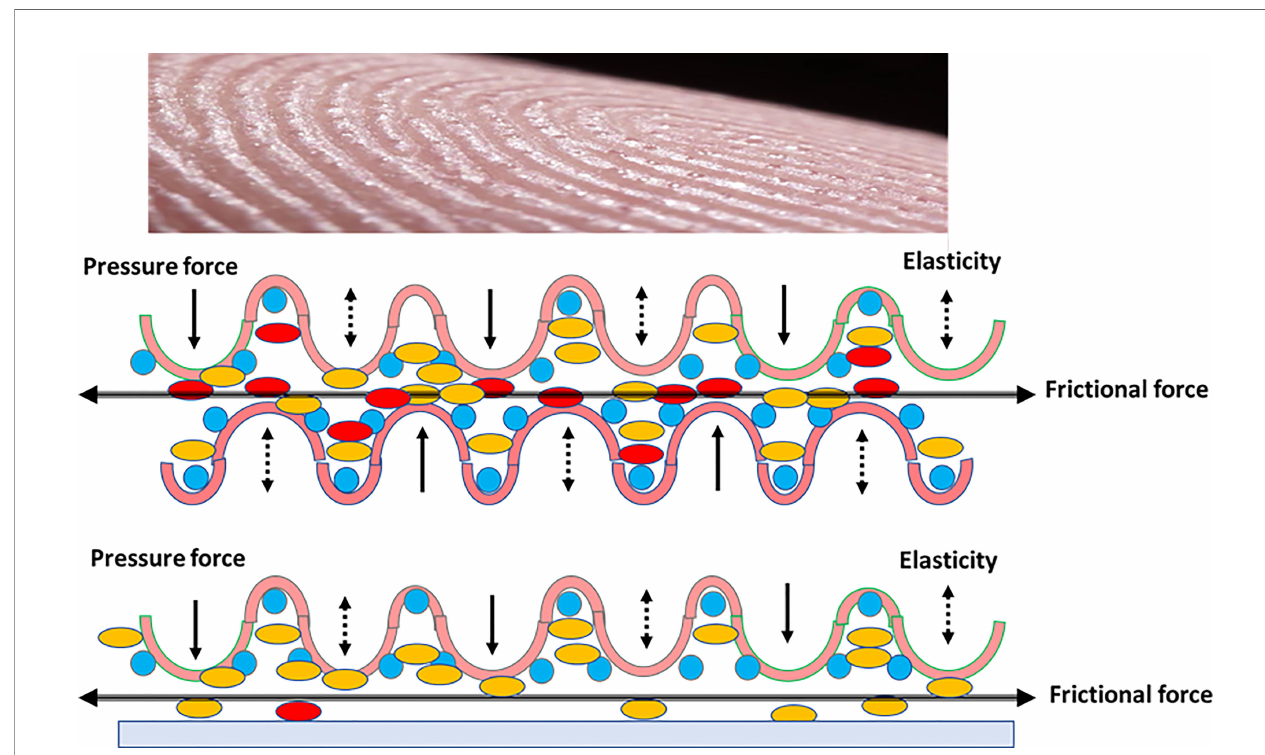
FIGURE 2 | Epidermis tribology. Up in the fi gure, the surface of a fi nger pad, showing the epithelial pad crests. Below, two rubbing series of friction (beheaded arrow) fi nger pad crests. Because of the pressure and frictional forces (black arrows), and elasticity of the dermal compartment, the (yellow) bacteria of the upper epithelium frequently migrate to the lower epithelium, and only some of the (red) bacteria are transmitted to the green epithelium. The asymmetry of transmission might be due to microecological differences, for instance water content (blue circles). Down in the slide, if the epidermis is rubbed on a smooth surface, the transmission is much less